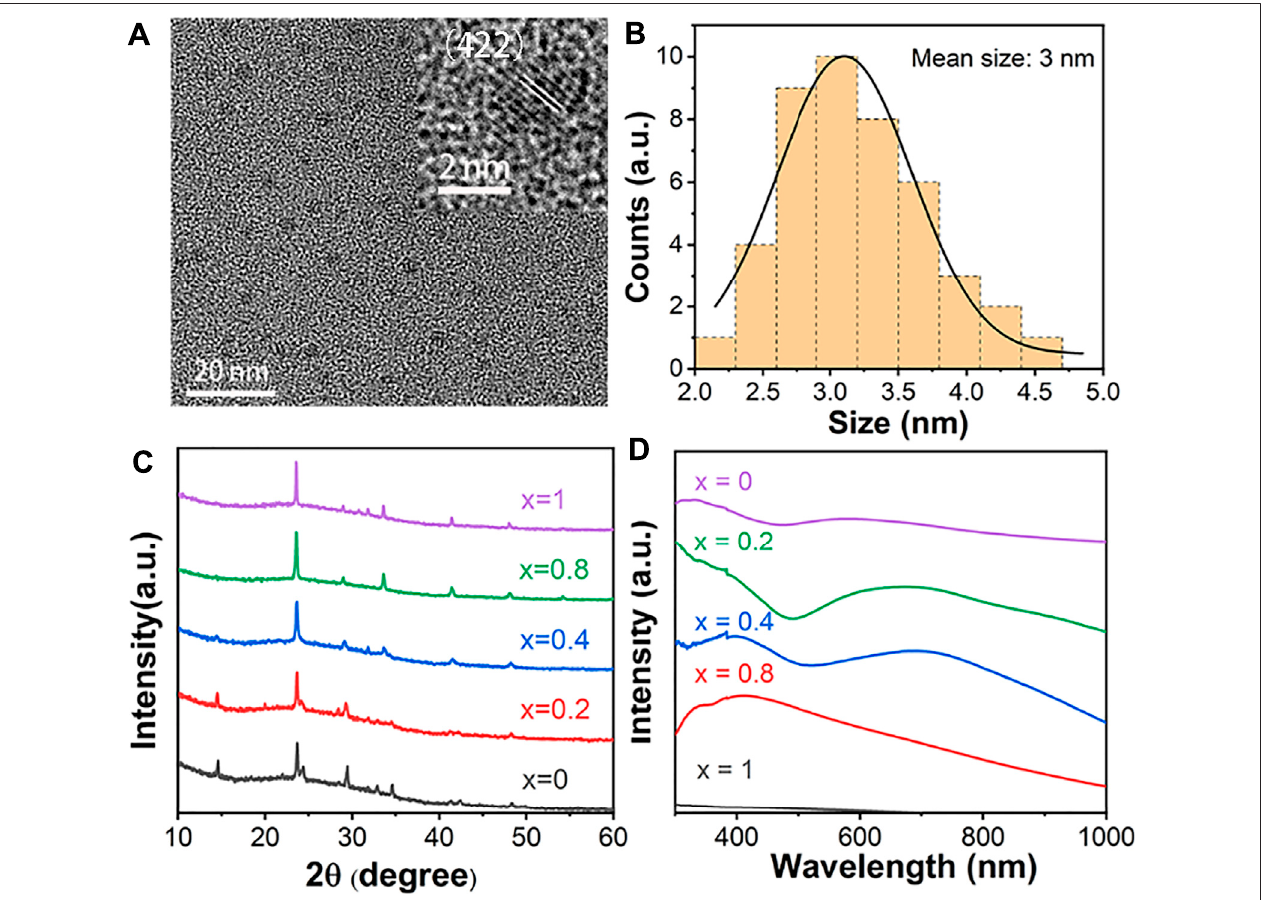
FIGURE3|(A) TEMandHRTEM(insert)imagesofCs 4 Cu 0.2 Ag 1.6 Sb 2 Cl 12 NCs. (B) ThesizedistributionhistogramofCs 4 Cu 0.2 Ag 1.6 Sb 2 Cl 12 NCs. (C) XRDpatterns of Cs 4 Cu 1-x Ag 2x Sb 2 Cl 12 (x = 0, 0.2, 0.4, 0.8, 1) NCs. (D) Absorption spectra of Cs 4 Cu 1-x Ag 2x Sb 2 Cl 12 (x = 0, 0.2, 0.4, 0.8, 1)